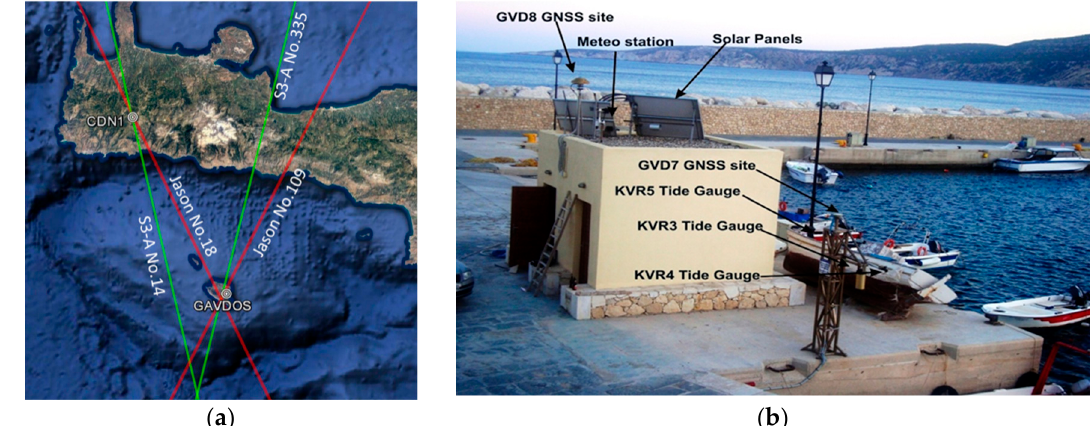
Figure 4. ( a ) The location of the Gavdos sea-surface Cal/Val facility enables the provision of calibration services for Sentinel-3A (green) andJason (red) satellite altimetry missions. Ascending and descending passes for both missions are calibrated at the Gavdos Cal/Val facility. ( b ) The current setup of the “Karave” harbor site in the Gavdos Cal/Val facility.